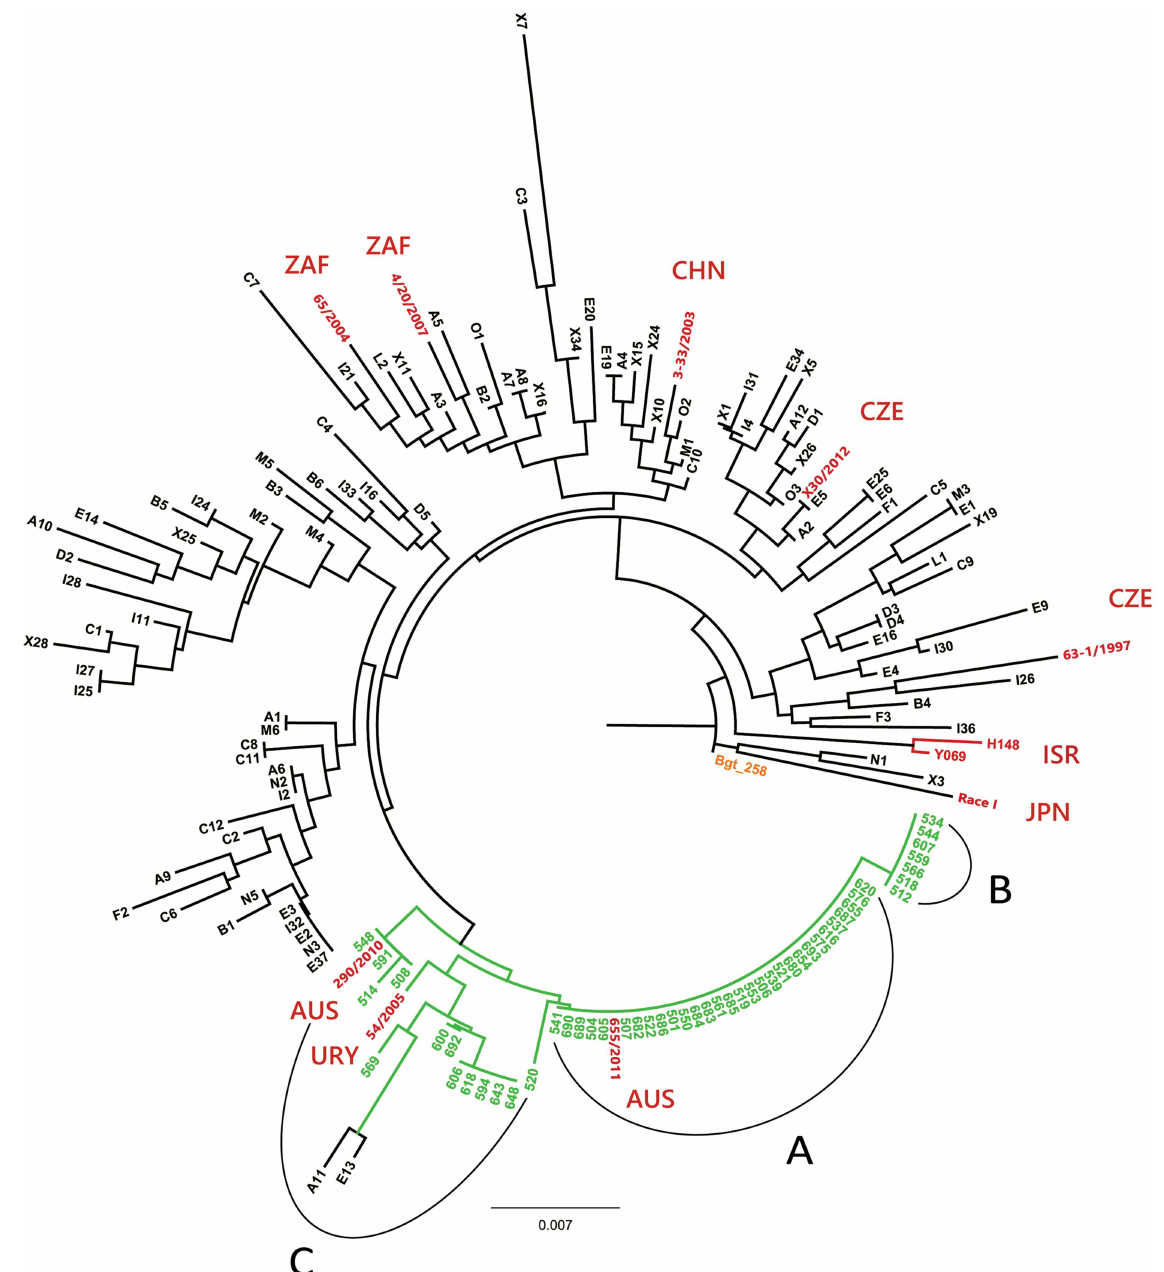
Fig 2. Resolution of the markerpanel demonstrated using phylogenetic tree. Phylogenetic tree of Blumeria graminis f. sp. hordei ( Bgh )isolates basedon 33 polymorphisms (RJMs, SSRs, SNPs). The outgroup( Bgt ) isolate Bgt258 is highlightedin orange, Australianisolates collectedin 2011 are marked green, isolates of the worldwidecollection(CHN = China, CZE = Czech Republic, ISR = Israel, JPN = Japan, URY = Uruguay,ZAF = South African Republic)are highlightedin red and the remainingisolates in black originatefrom collectionmade in the Czech Republicin 2012. Letters A, B and C delimit three sectionsof highly similar Australian isolates. Please note that only few Czech isolated remainedundistinguishedproving high resolutionpower of the marker